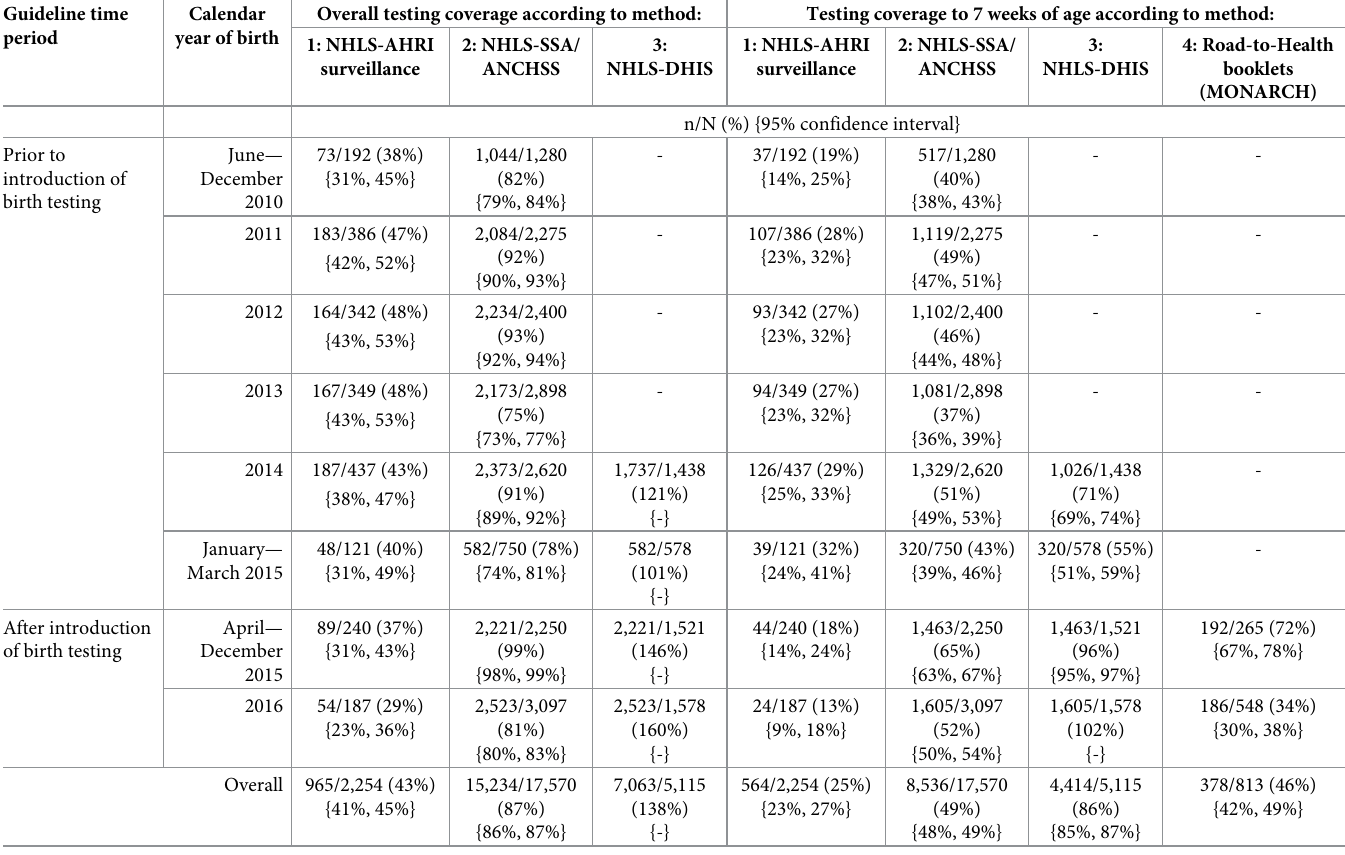
Table 2. Comparison of estimates of testing